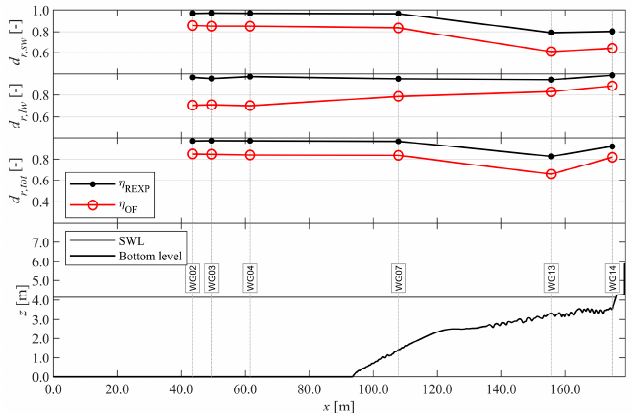
Figure 9. Index d r of REXP and OF with EXP up to the dike toe. From top to bottom: d r,sw for η SW , d r,lw for η LW , d r,tot for η , and finally an overview of the sensor locations, SWL , and bottom profile. Table 3. Pattern and model performance statistics for all η measurement locations.